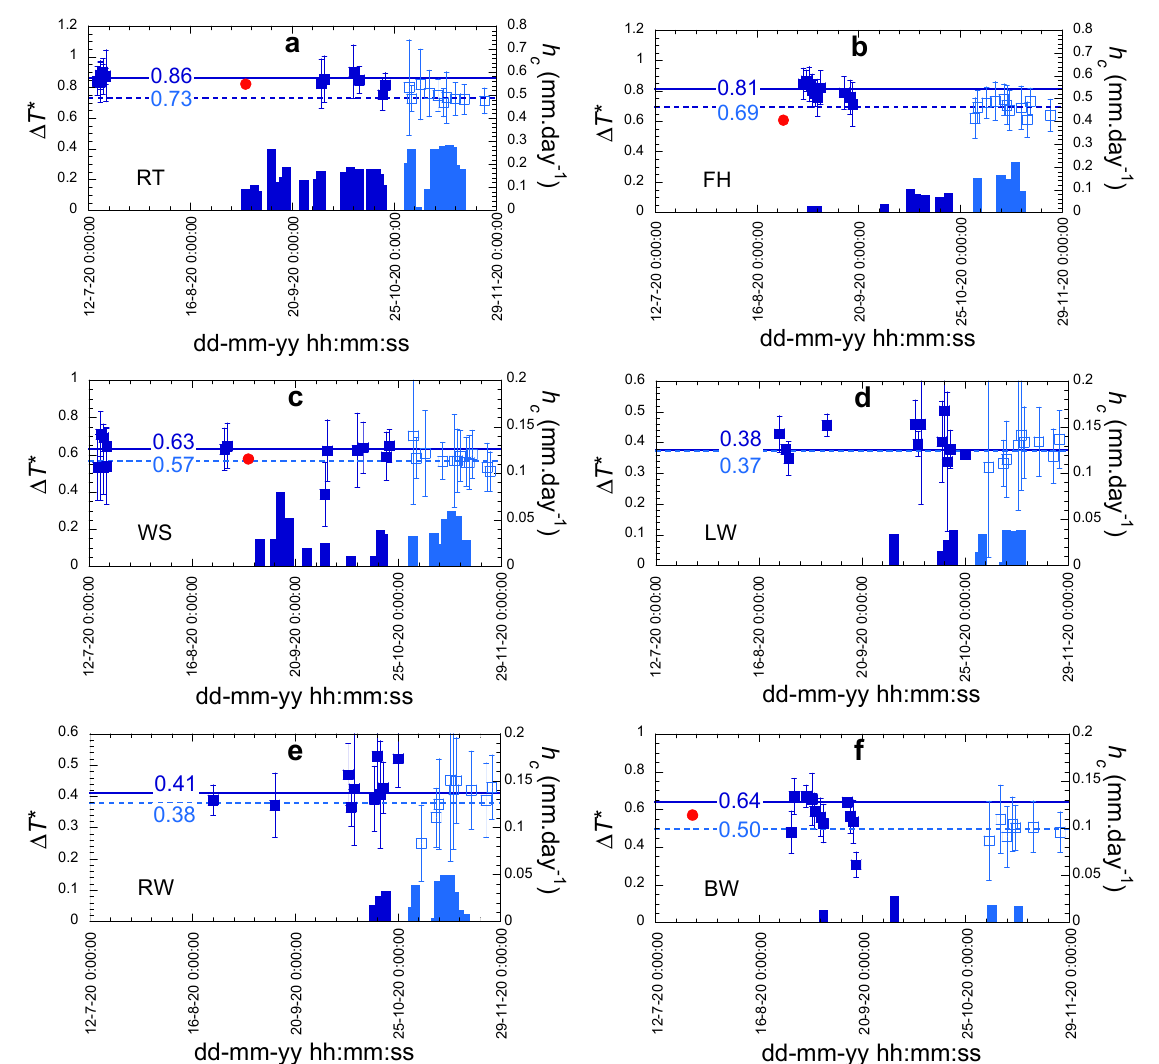
Figure 11. Daily mean relative cooling efficiencies ∆ T ∗ and daily dew yield h c (mm · day − 1 ) for the different car surfaces during condensation ( T j − T d ) < 0 in Ajaccio. Error bars correspond to one SD. ( a ) rooftop RT; ( b ) front hood FH; ( c ) windshield WS; ( d ) left window LW; ( e ) right window RW; ( f ) back window BW; ∆ T ∗ data: Full squares (VW) and open squares (AD). Dew yield data: Dark bars (VW) and light bars (AD). The value for Valparaiso is indicated for comparison by a red circle (BT is compared with FH).